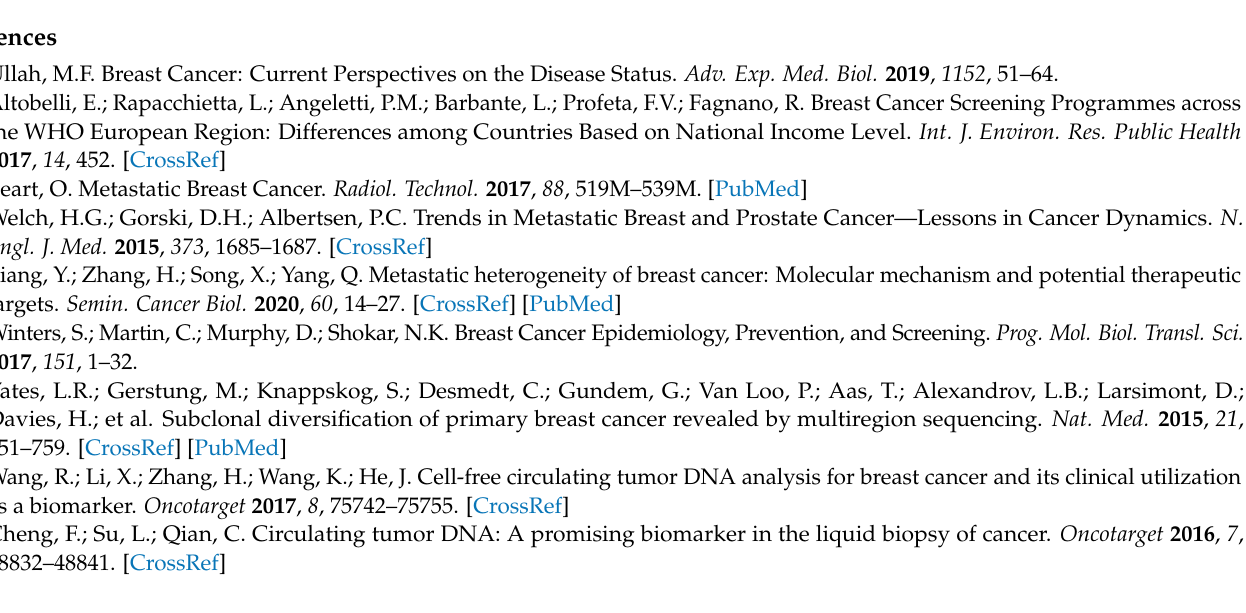
Table S1: Details of the personalized target-capture sequencing panel, Table S2: Analyses for the distribution of ctDNA mutations for all patients, Table S3: GO analysis for the mutated genes of three subsets, Table S4. KEGG analysis for the mutated genes of three